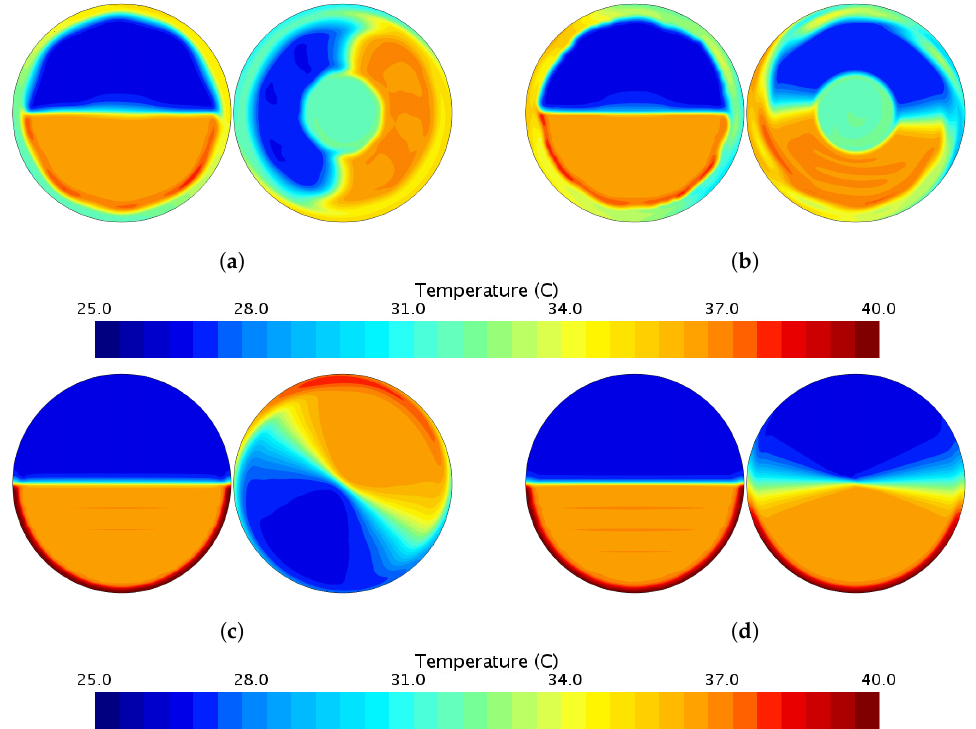
Figure 4. Temperature field at the MRF upstream and downstream interfaces for the case with ( a ) and the corresponding rigid body motion (RBM) result ( b ). ( a ) MRF with blades; ( b ) RBM with blades; ( c ) MRF without blades; ( d ) RBM without